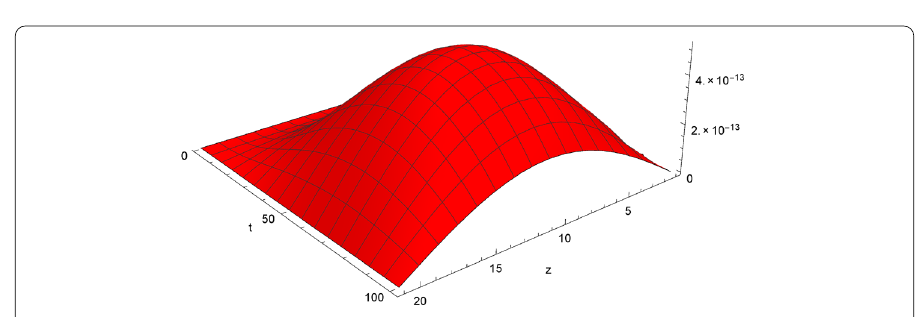
Figure 3 Absolute error graph for Example 1 at t = 1 when N = 20, α = 1.3 and 0 ≤ z ≤